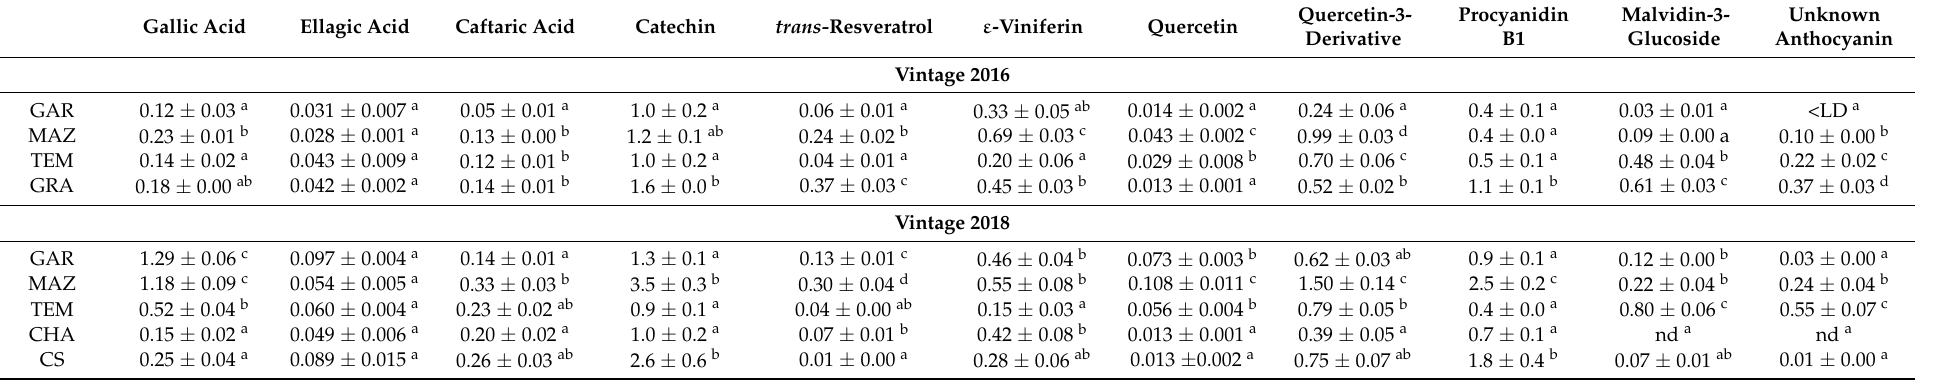
Table 3. Phenolic composition (mg/g extract) of the different grape stem extracts analyzed in this study (mean ±